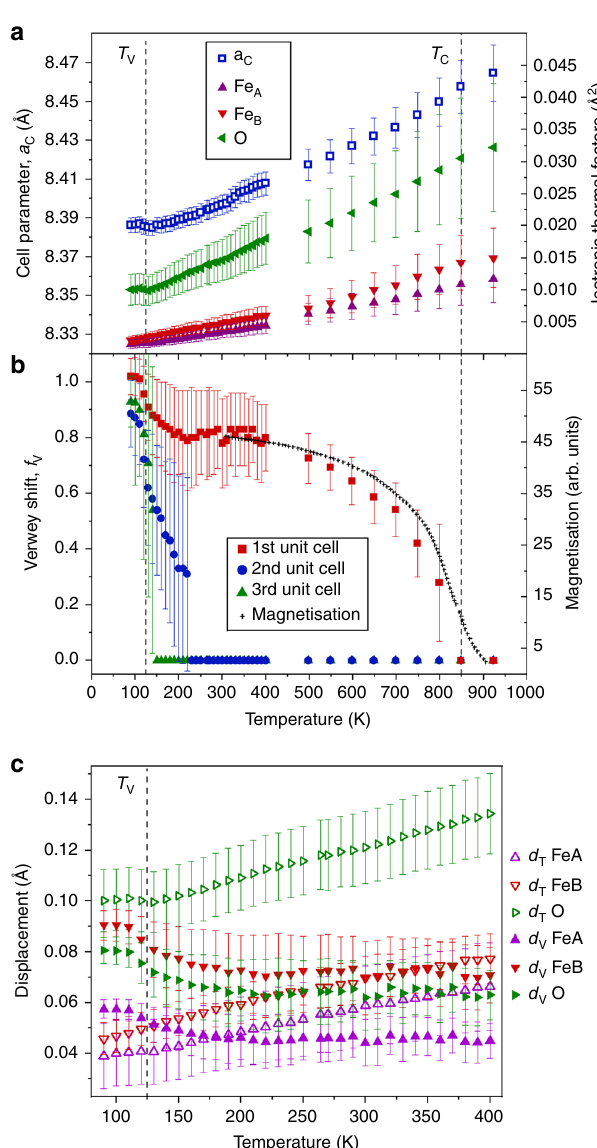
Fig. 3 Thermal variations of parameters from magnetite pair distribution function (PDF) fi ts. a Isotropic temperature factors U iso s for tetrahedral Fe A , octahedral Fe B , and oxygen sites and the cubic cell parameter from fi ts to the First Unit Cell PDF range. b Verwey shifts f V fi tted to First, Second and Third Unit Cell PDF ranges. f V represents the magnitude of structural distortions due to electronic fl uctuations in the cubic phase of magnetite above T V . The First Unit Cell values show that substantial local structural distortions persist up to T C and closely match the variation of bulk magnetisation data taken from ref. 18 . This demonstrates that the structural and electronic fl uctuations responsible for the Verwey transition are a direct result of the long-range magnetic order. c Comparison of the atomic displacements due to electronic fl uctuations d V , calculated from atomic coordinates for the First Unit Cell f V values, and those due to thermal motion taken as d T = √ U iso from values shown in a . Error bars are estimated standard deviations from the re fi